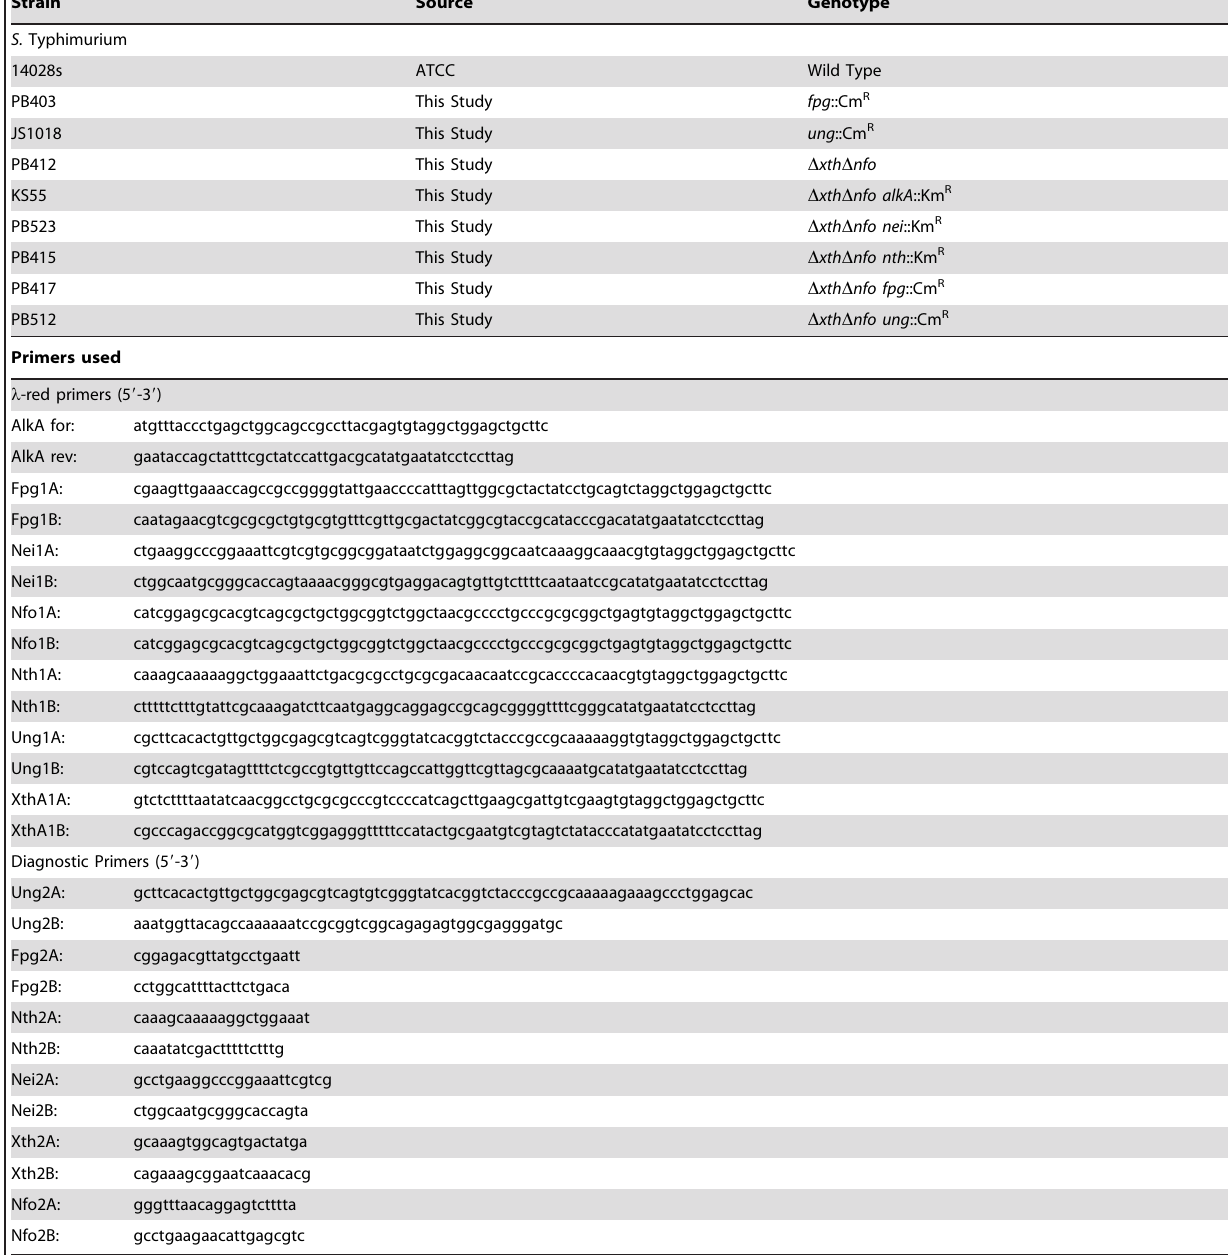
Bacterial strains used Strain Source Genotype